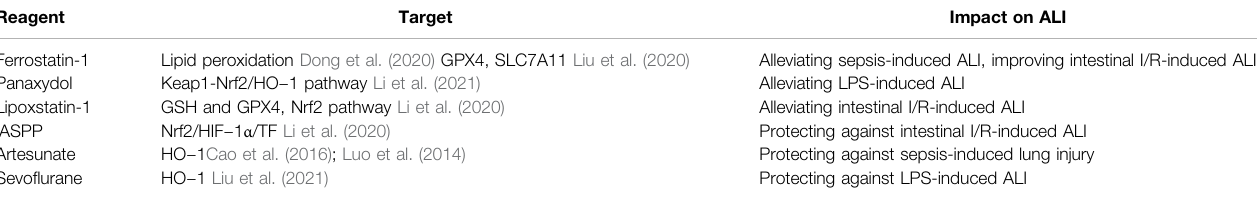
TABLE 3 | Impact of ferroptosis inhibitors on